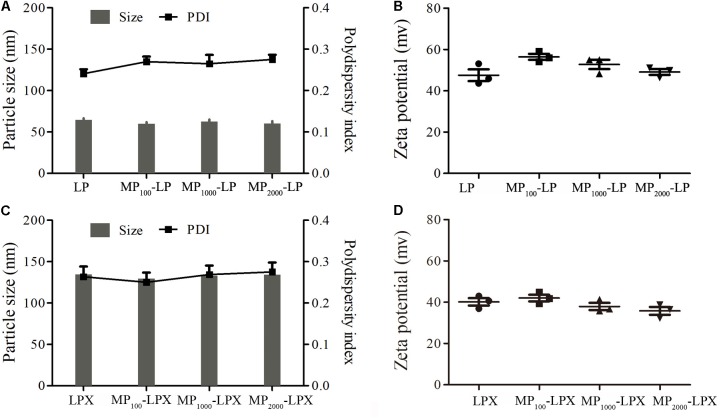
Physicochemical properties of MPn-LPs and MPn-LPX. Size (A) and zeta potential (B) of MPn-LPs with different PEG linkers. Size (C) and zeta potential (D) of different formulations loaded with mRNA.